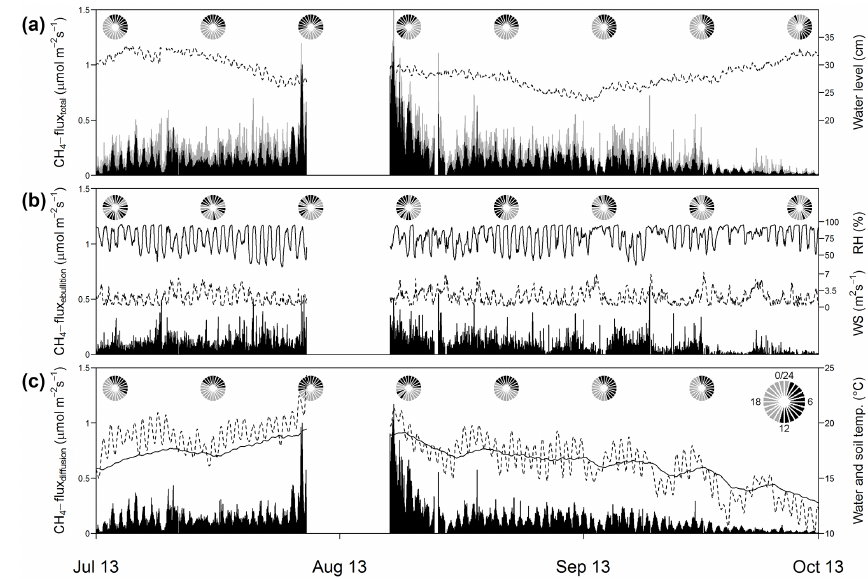
Figure 6. Time series of (a) total CH 4 emissions with proportions of ebullition (grey bar) and diffusion flux components (black bar) during the study period from July until September 2013. Figure 6b and c show the separated flux components ( b ebullition and c diffusion), together with the development of important environmental parameters, which are assumed to explain their specific dynamics ( a water level, b RH and wind speed and c sediment (solid line) and water temperature (dashed line)). Pie charts represent the biweekly pooled diurnal cycle of measured CH 4 fluxes. Slices are applied clockwise, creating a 24h clock, with black and light grey slices indicating hours with CH 4 flux above and below the daily mean,